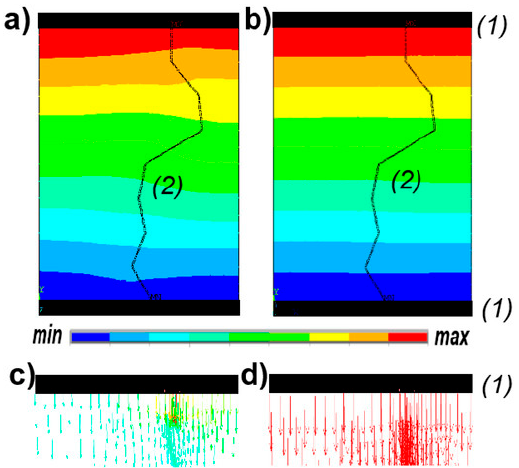
Figure 7. Electric potential distribution ( a , b ) and electric field gradients ( c , d ) distribution for nonlinear parameters ( ε , ρ ) after 0.5 s ( a , c ) and 1 s ( b , d ) from previous discharge. 1—electrode; 2—geometry of previous discharge channel [33].